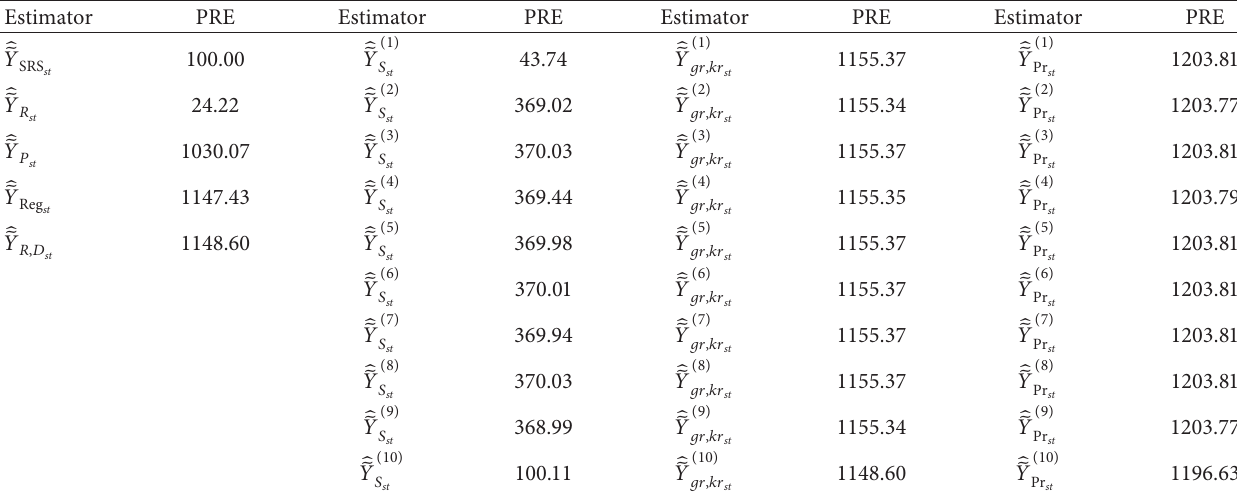
Table 11: PREs of finite population mean estimators using population 1 (scenario I).